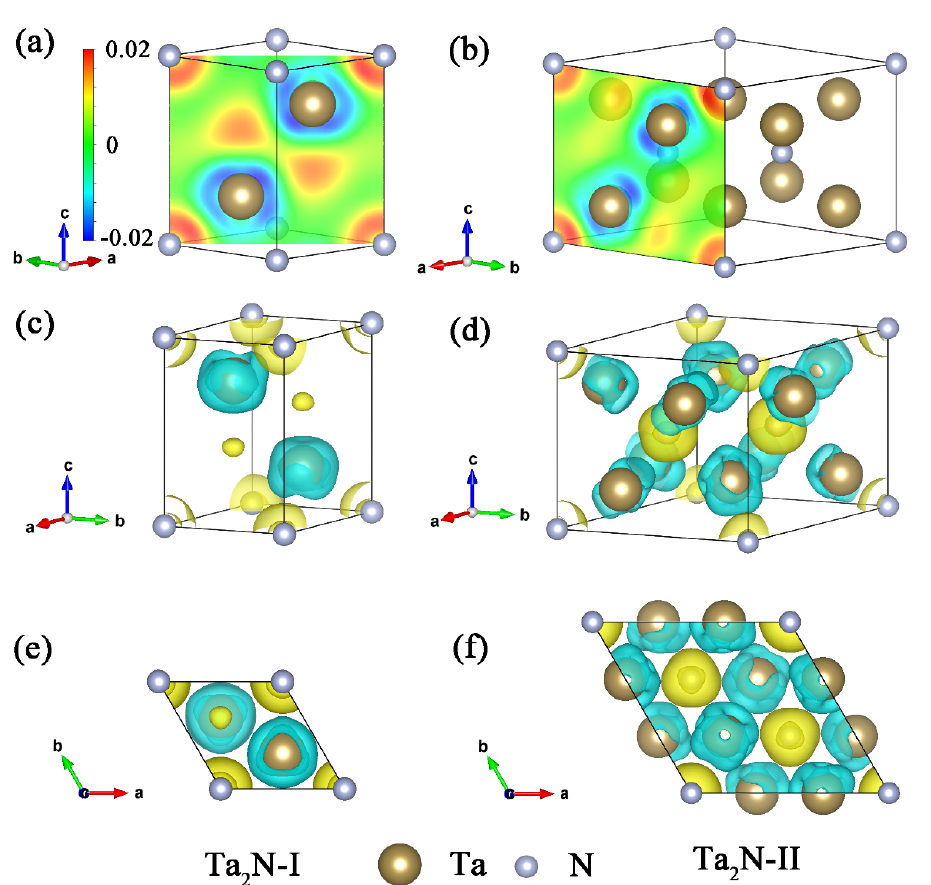
Figure 6. The sectional view of charge density difference of the (110) lattice plane in ( a ) Ta 2 N-I and the (100) lattice plane in ( b ) Ta 2 N-II. The side view and top view of charge density difference of ( c , e ) Ta 2 N-I and ( d , f ) Ta 2 N-II. The isosurface value is taken as 0.015 e/Å 3 .